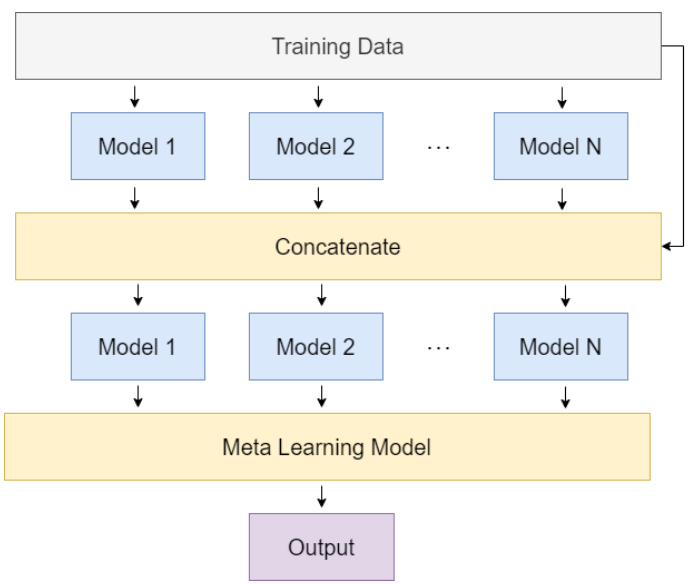
Figure 3. Multi-layer stack ensemble in